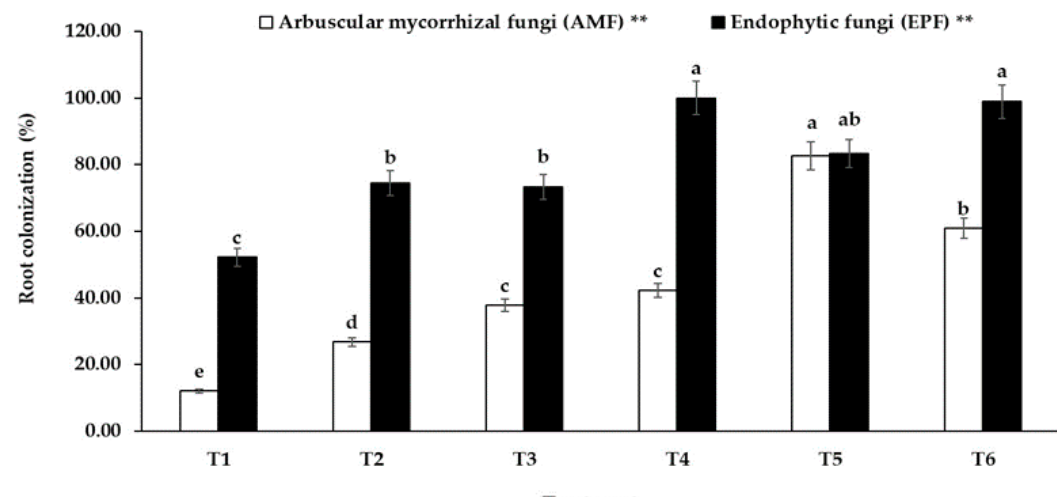
Figure 2. Root colonization (%) of AMF and EPF in sunchoke roots at 90 days after planting. Treatments are indicated as follows: (T1) uninoculated plants, (T2) full-dose chemical fertilizer-treated plants, (T3) half-dose chemical fertilizer-treated plants, (T4) EPF-inoculated plants, (T5) AMF-inoculated plants, and (T6) co-inoculation of EPF and AMF-treated plants. Error bars represent standard deviations of four replicate data. Different letters above the bars indicate significant differences. ** Significant difference at p ≤ 0.01.